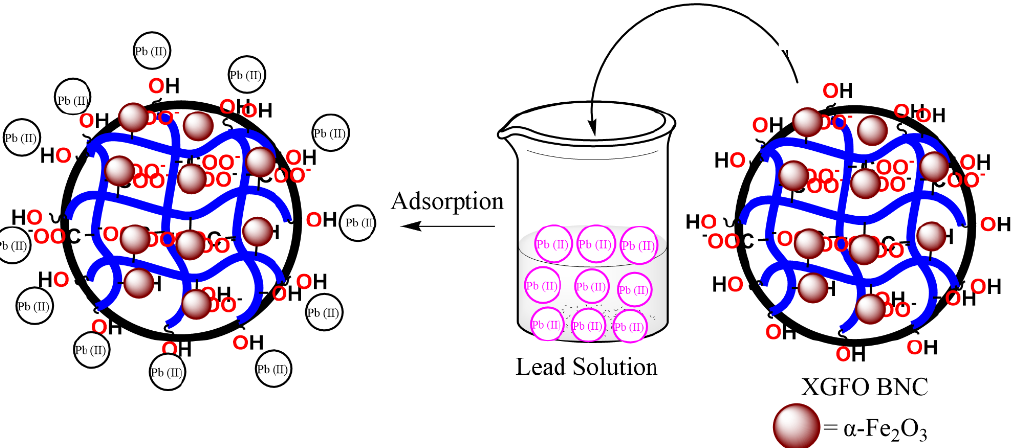
Scheme 2. Illustration of Pb (II) uptake mechanism by XGFO BNC under optimized condition.